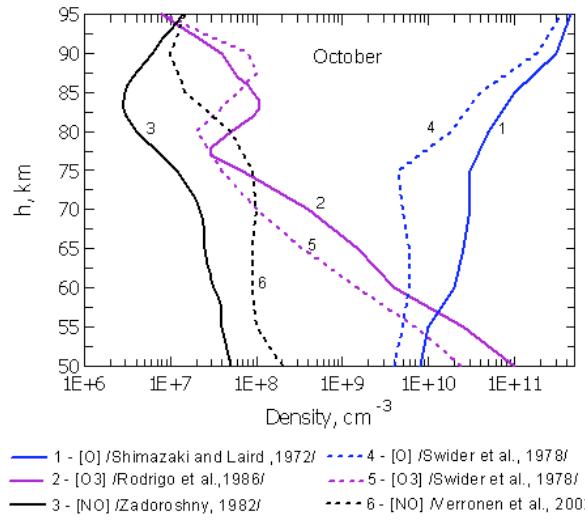
Fig. 1b. Autumn: Input values of atomic oxygen (curves 1 and 4), ozone (curves 2 and 5) and nitric oxide (curves 3 and 6) concentra- tions. Curves 1–3 – during quiet conditions; curves 4–6 – during SPE. All profiles for χ< 90 ◦